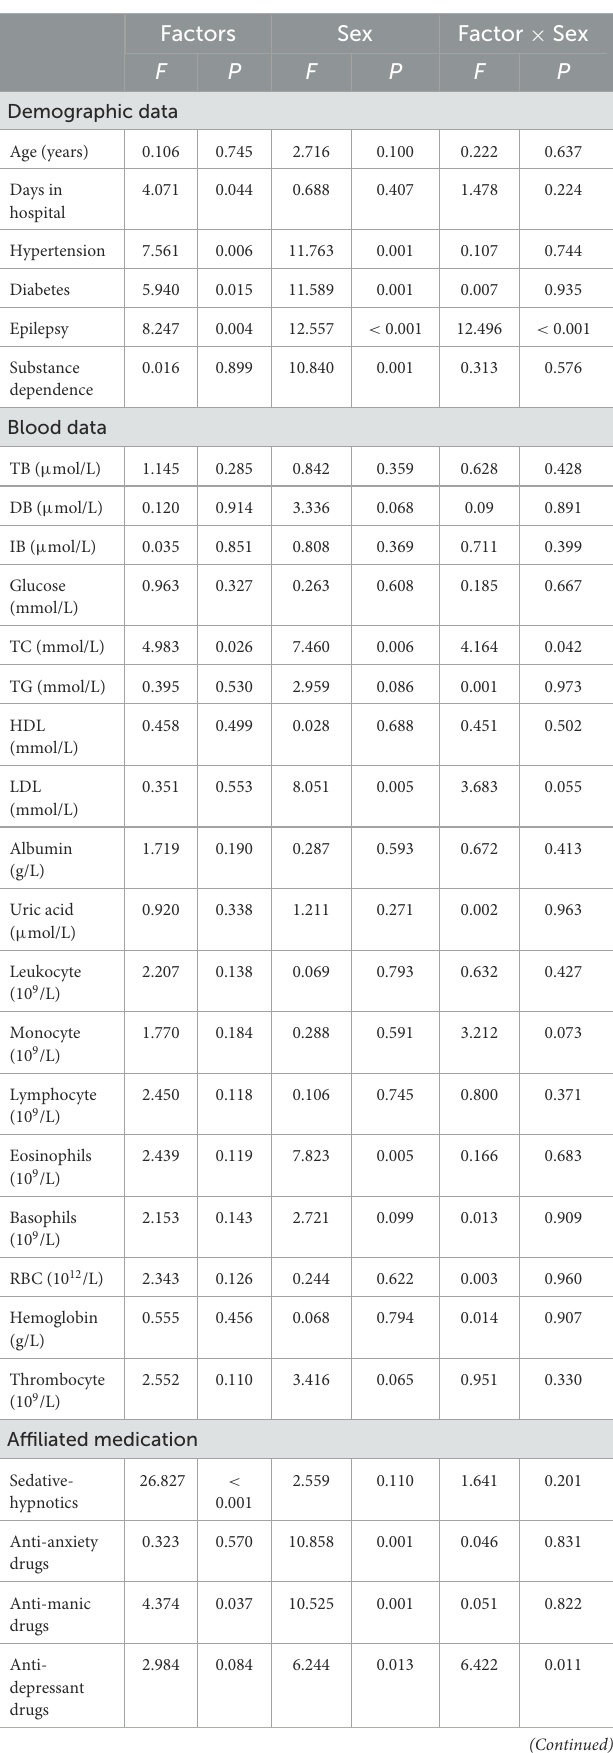
TABLE 1 Interaction effect between influencing factors and sex on hospital-acquired pneumonia (HAP). Factors